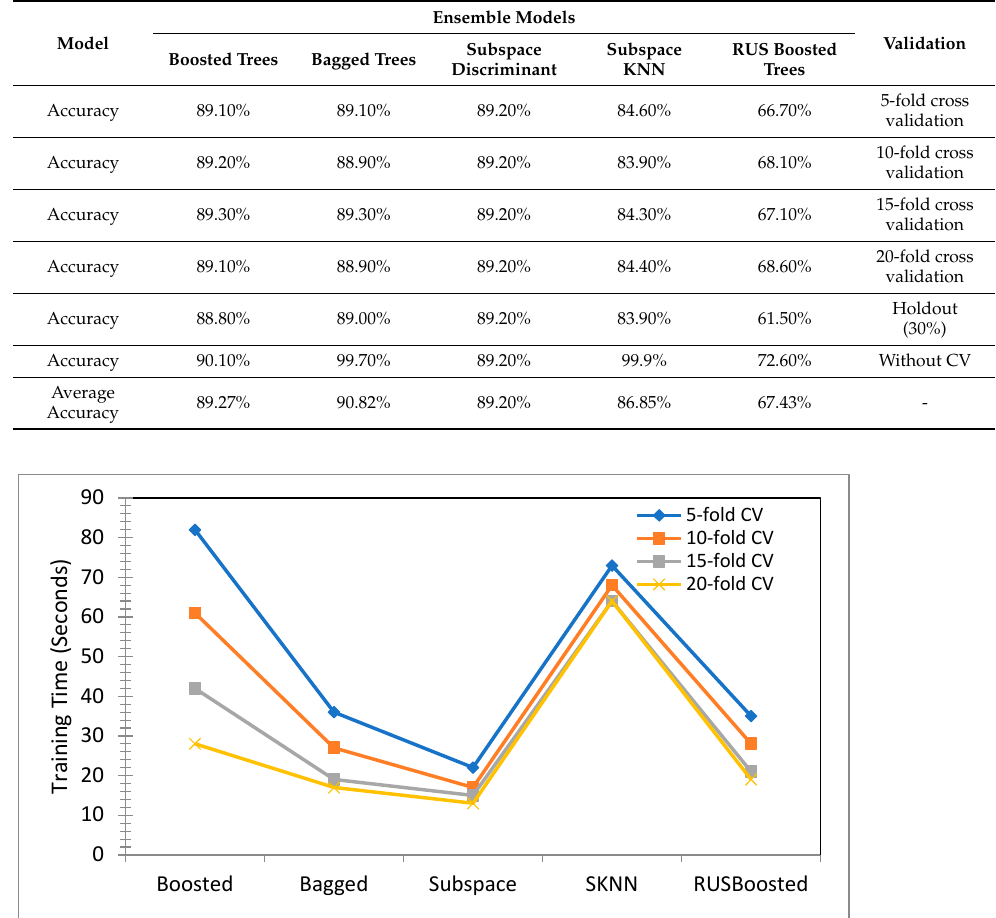
Figure 7. Training time comparison on various cross validations after performing the dimensional- ity reduction.